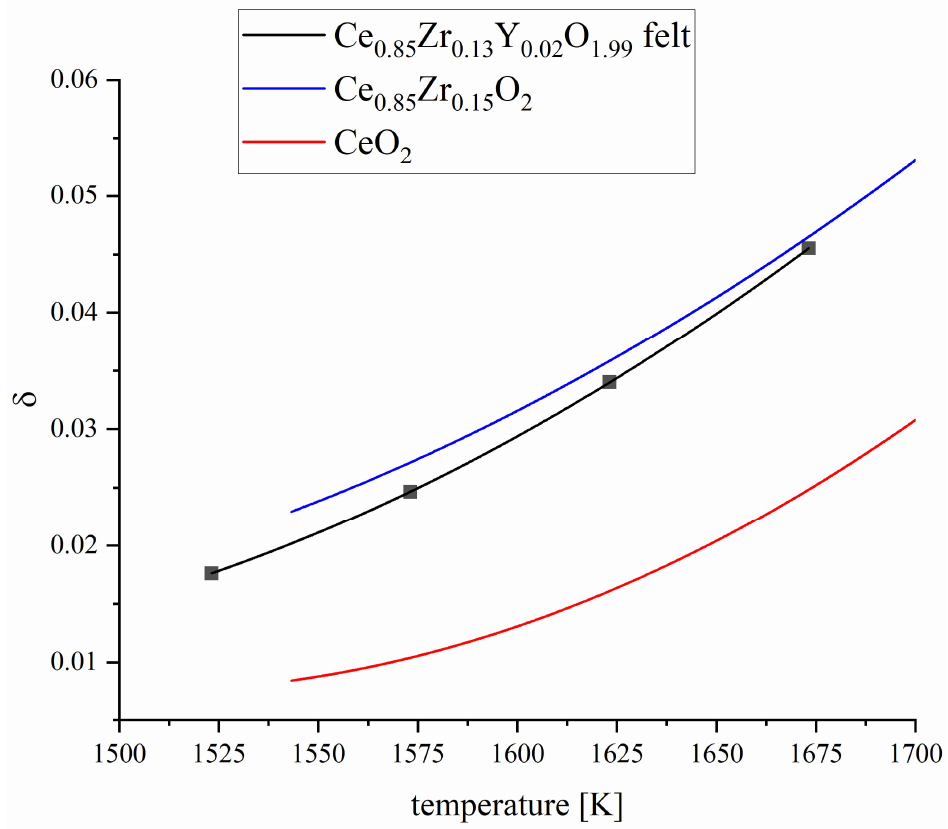
Figure 12. Calculated vacancy concentration δ of Ce 0.85 Zr 0.13 Y 0.02 O 1.99 in comparison to literature data of CeO 2 and Ce 0.85 Zr 0.15 O 2 measured under the same conditions